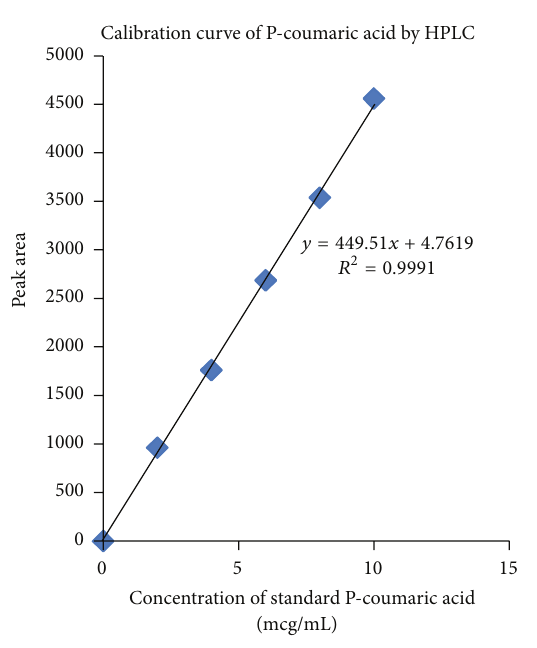
Figure 5: Linearity plot for P-coumaric